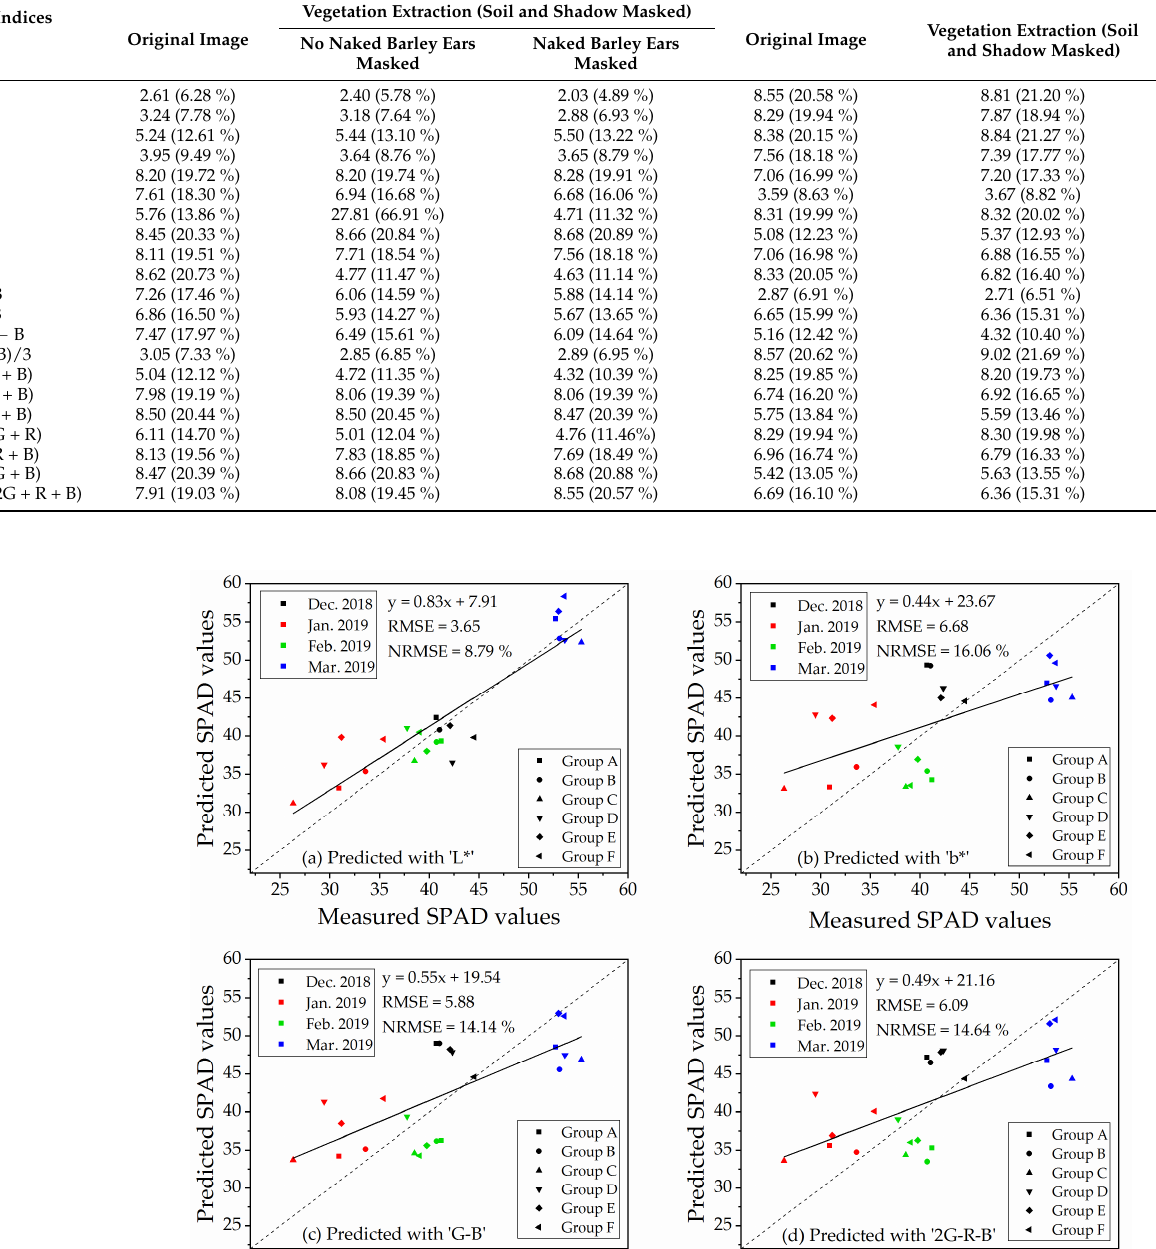
Vegetation Indices